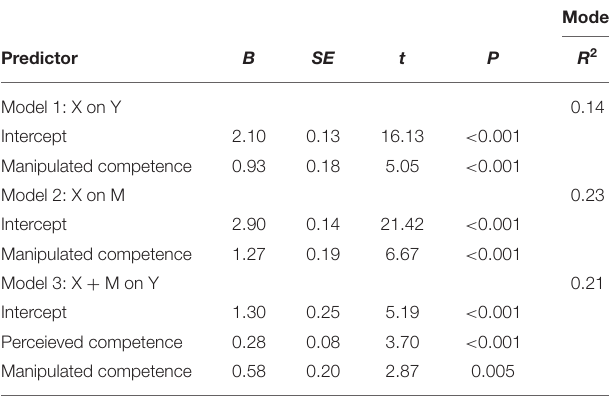
TABLE 3 | Mediated regression analysis testing the effect of manipulated competence on anticipated trust mediated by perceived competence within study